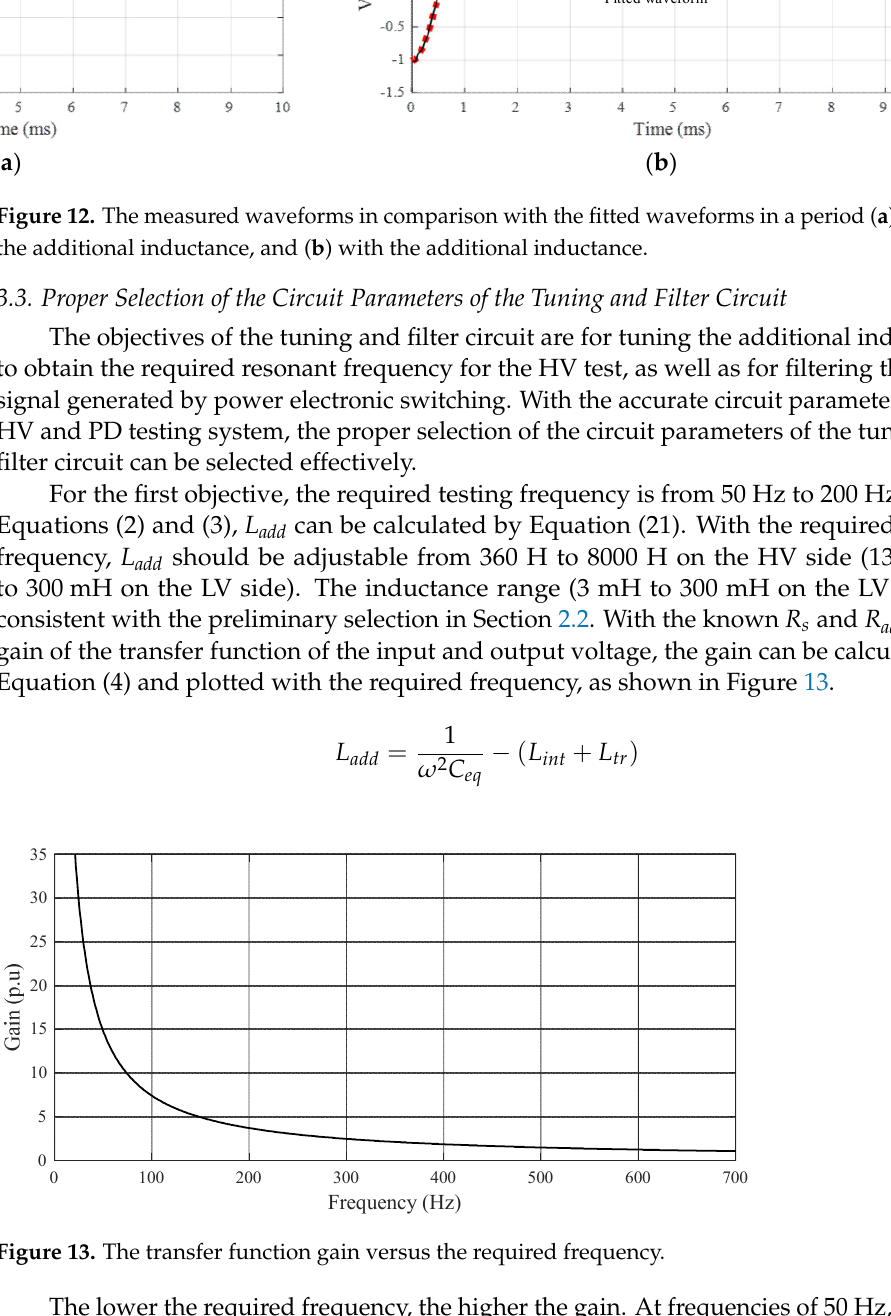
Table 2. The additional inductances and resistances.